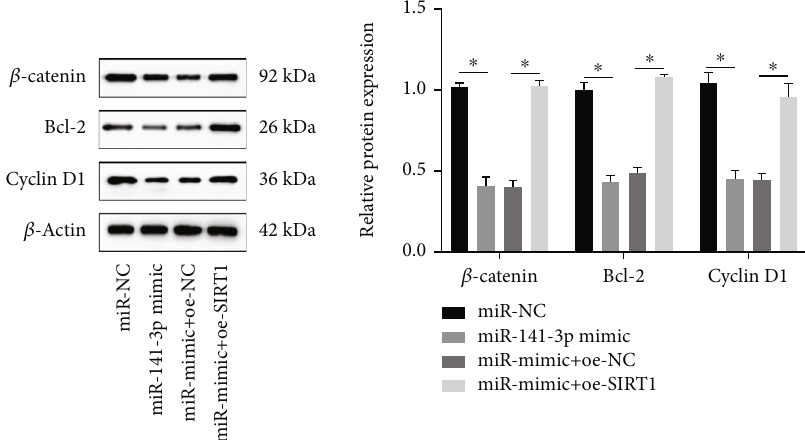
Figure 5: miR-141-3p suppressed Wnt/ β -catenin signaling pathway to inhibit osteogenesis. ∗ P < 0 : 05